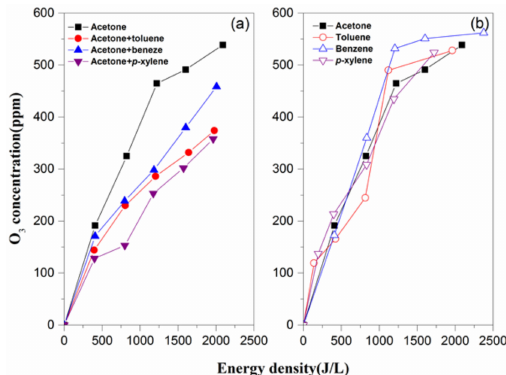
Figure 4. Effects of energy density on the O 3 concentrations of the binary ( a ) and single-component ( b ) VOC degradation processes. Reaction conditions: acetone: 250 ppm, BTEX: 50 ppm, RH: 50%, and total flow: 2 L/min.